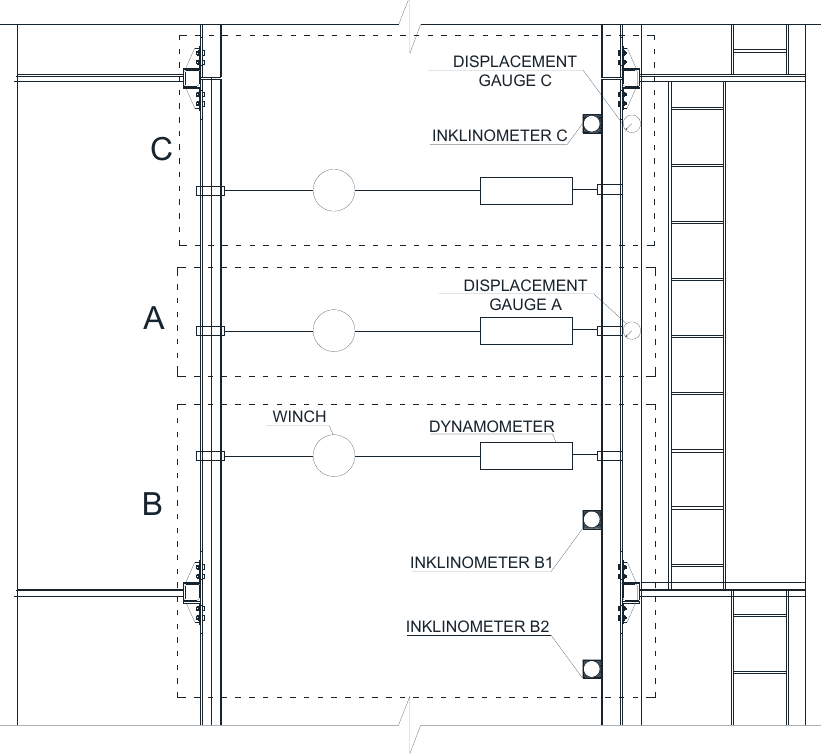
Figure 5. The three load schemes (A, B, and C) used for the field tests.